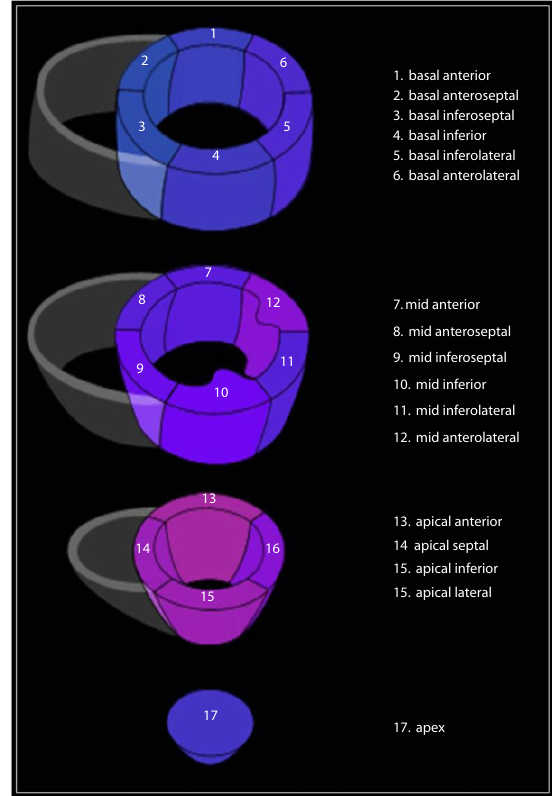
Figure 2. Schematic representation of the 17 left ventricular segments as recommended by the American Heart Association Standardized Myocardial Segmentation and Nomenclature for Imaging Guidelines.